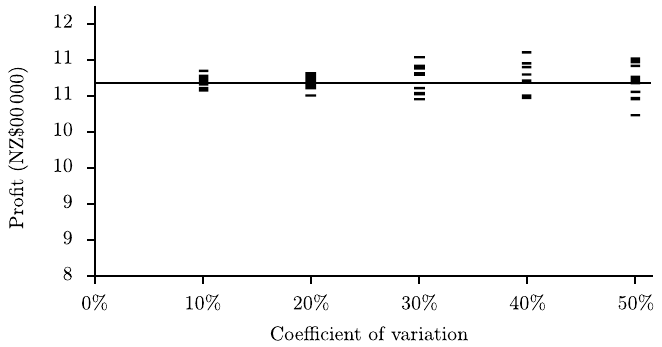
Figure 4: Fluctuation in the profit due to variability in catch rate of